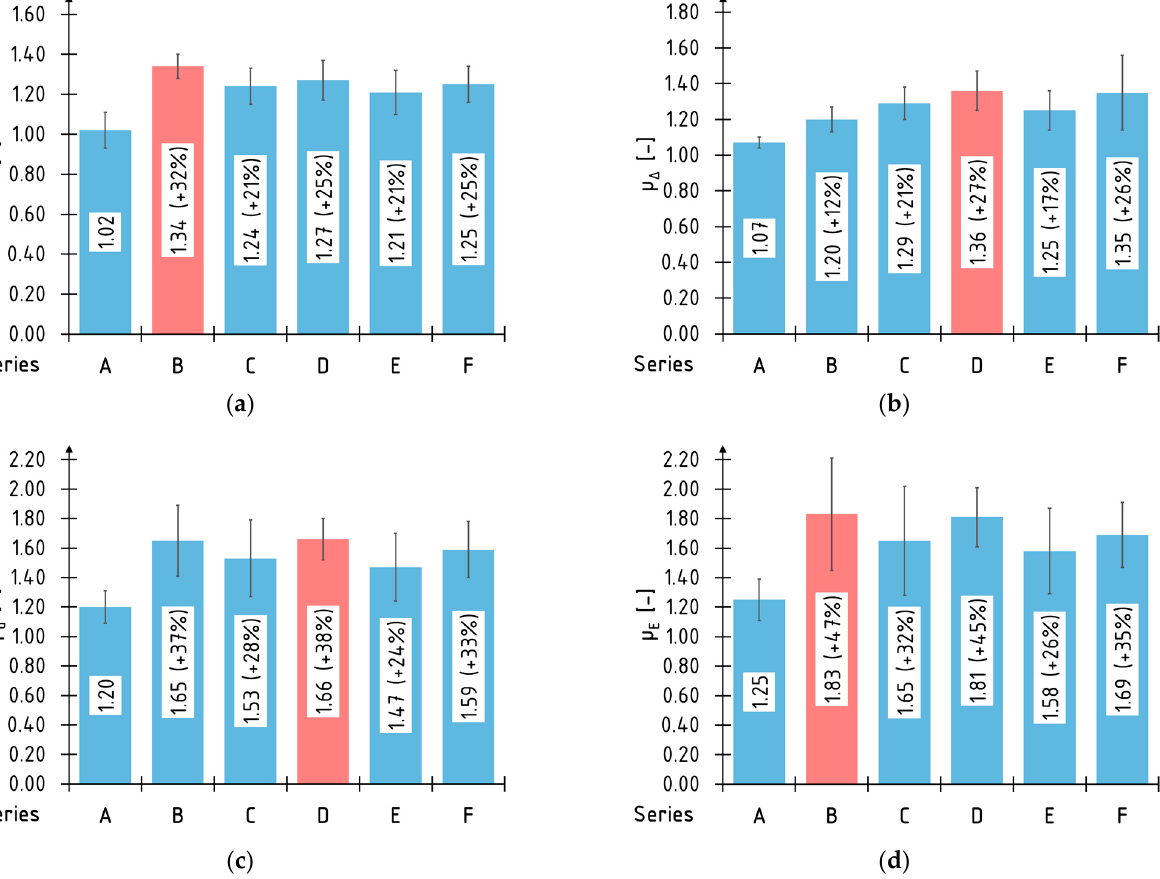
Figure 17. Average values and standard deviation of ductility indexes: ( a ) D ; ( b ) µ Δ ; ( c ) µ d ; ( d ) µ E . The highest percentage increases were obtained by applying the index based on µ E energy absorption, amounting to, respectively: above 40% for the B and D series beams; above 30% for the C and F series beams; and above 20% for the E series. The smallest ones applied the µ ∆ index. Parameter D has the most homogeneous (flattened results) values—it is related to the similar values of the deflection at the failure of the beams.